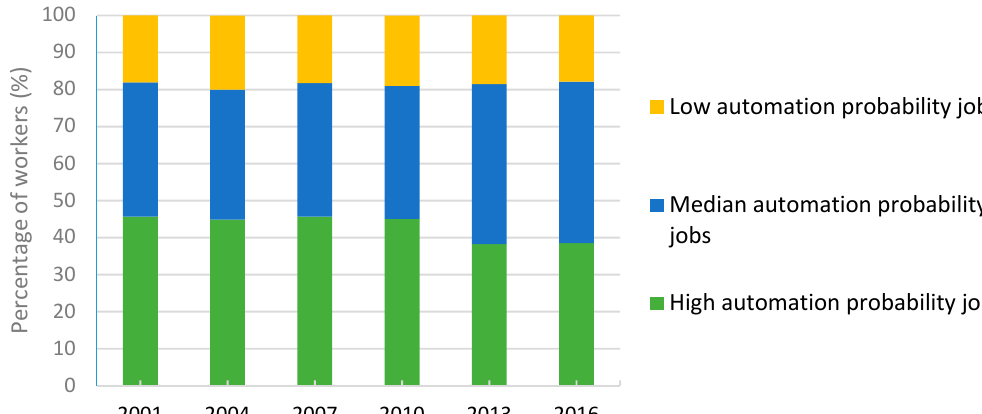
Figure 1. Temporal trends in number of workers in three levels of automation probability jobs. Number of participants in the six waves of survey were 14,691, 15,288, 17,042, 17,263, 16,530, and 14,948, respectively.